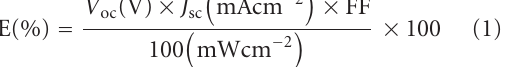
Table 1: Photovoltaic parameters obtained from J-V characteristics under solar simulator (AM 1.5 G), with the coatings of various surface